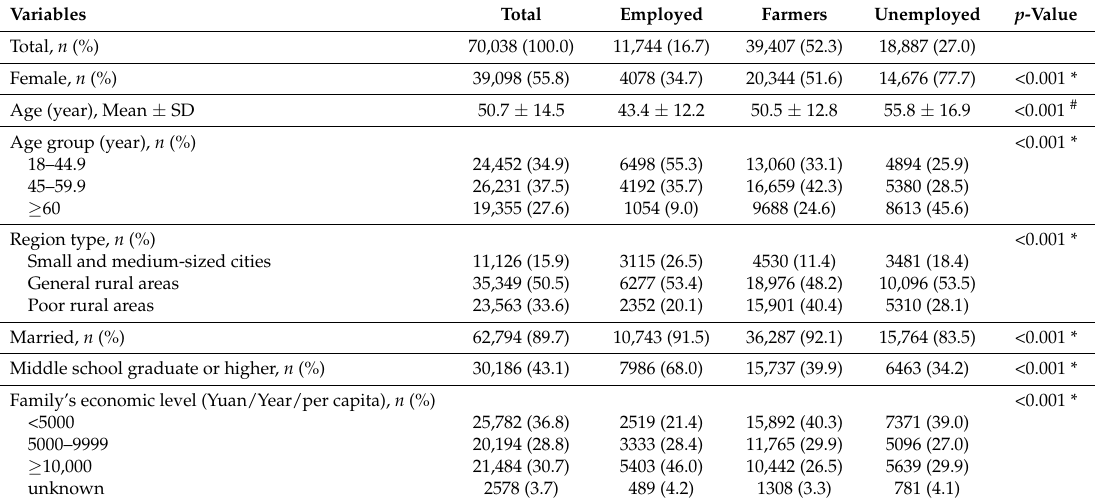
Table 1. Characteristics of the study subjects stratified by